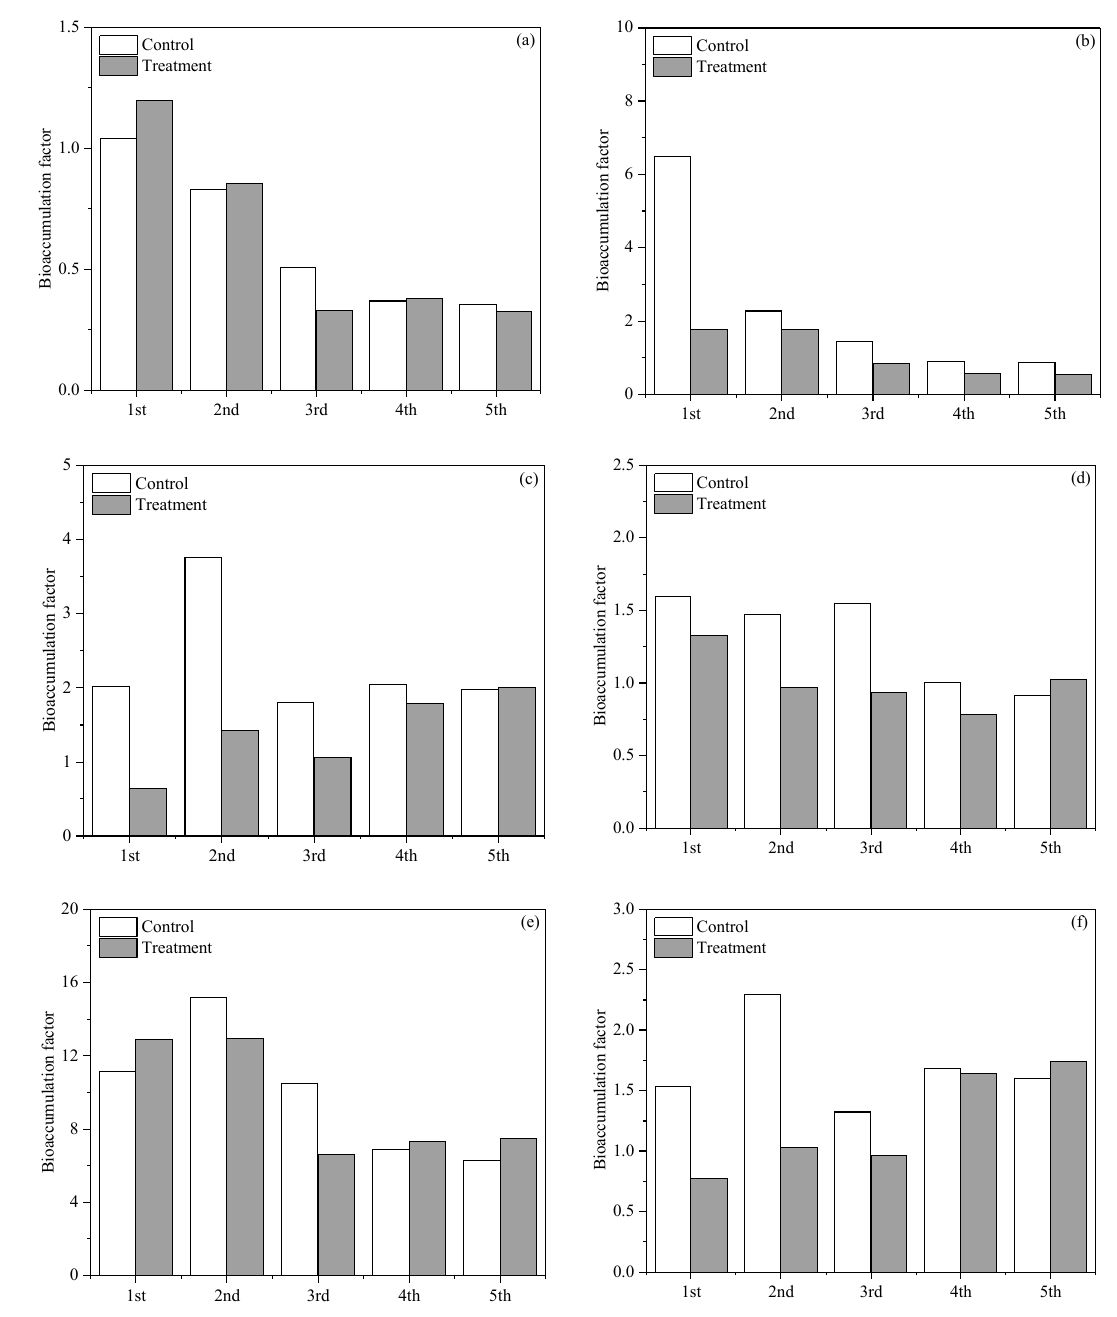
Figure 2. Bioaccumulation factor (BAF) of Cr ( a ), Ni ( b ), Cu ( c ), Zn ( d ), Cd ( e ), and Pb ( f ) for the Gynura cusimbua at different harvest times.